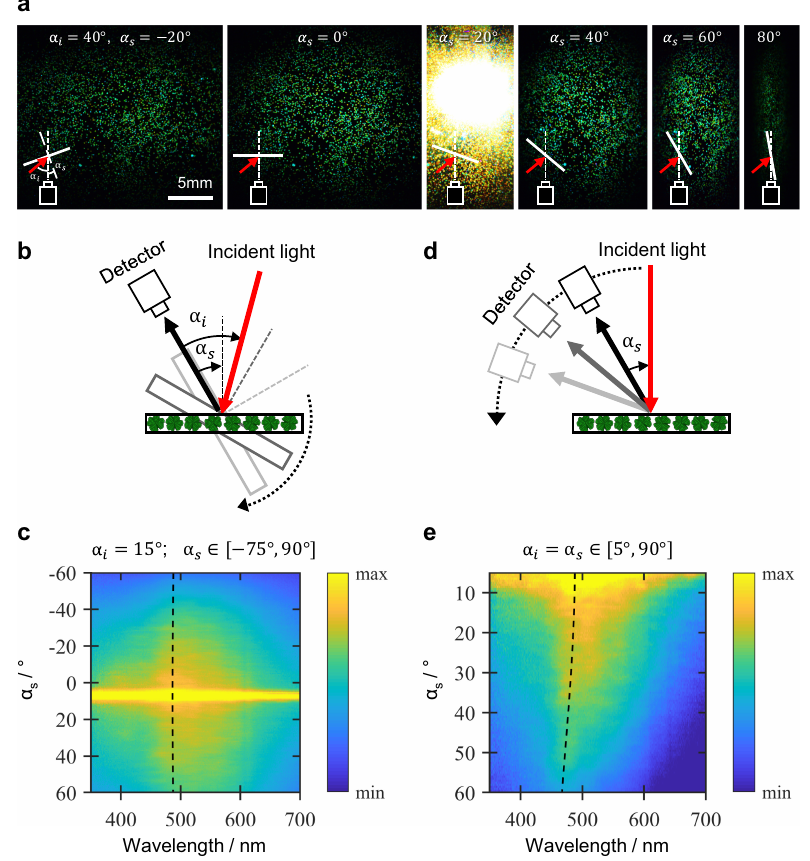
Fig. 7 Angular dependence analysis of the re fl ected colour of coatings containing CNC photonic microparticles. a Photographs showing a consistent green appearance for a PDMS fi lm embedded with CNC photonic pigments, upon rotating the sample with a fi xed illumination and viewing angle. Specular re fl ection from the fi lm interface is at α s = 20° ( b – e ) Angular resolved optical spectroscopy of the same PDMS fi lm recorded under two complementary sets of illumination and viewing conditions, as described in the schematics. Both conditions show a limited angular dependence for the re fl ection peak over this wide angular